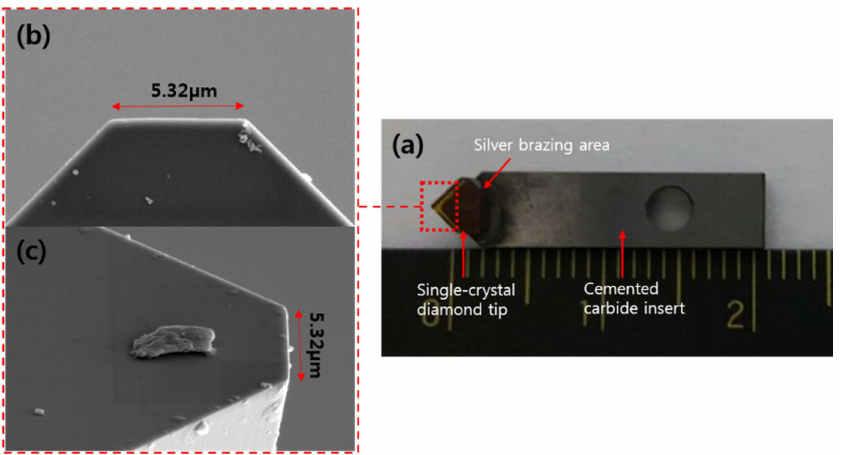
Figure 1. ( a ) Photograph of single-crystal diamond sample prepared with ultra-precision grinding; ( b ) SEM image of prepared diamond sample top view; ( c ) SEM image of prepared diamond sample side